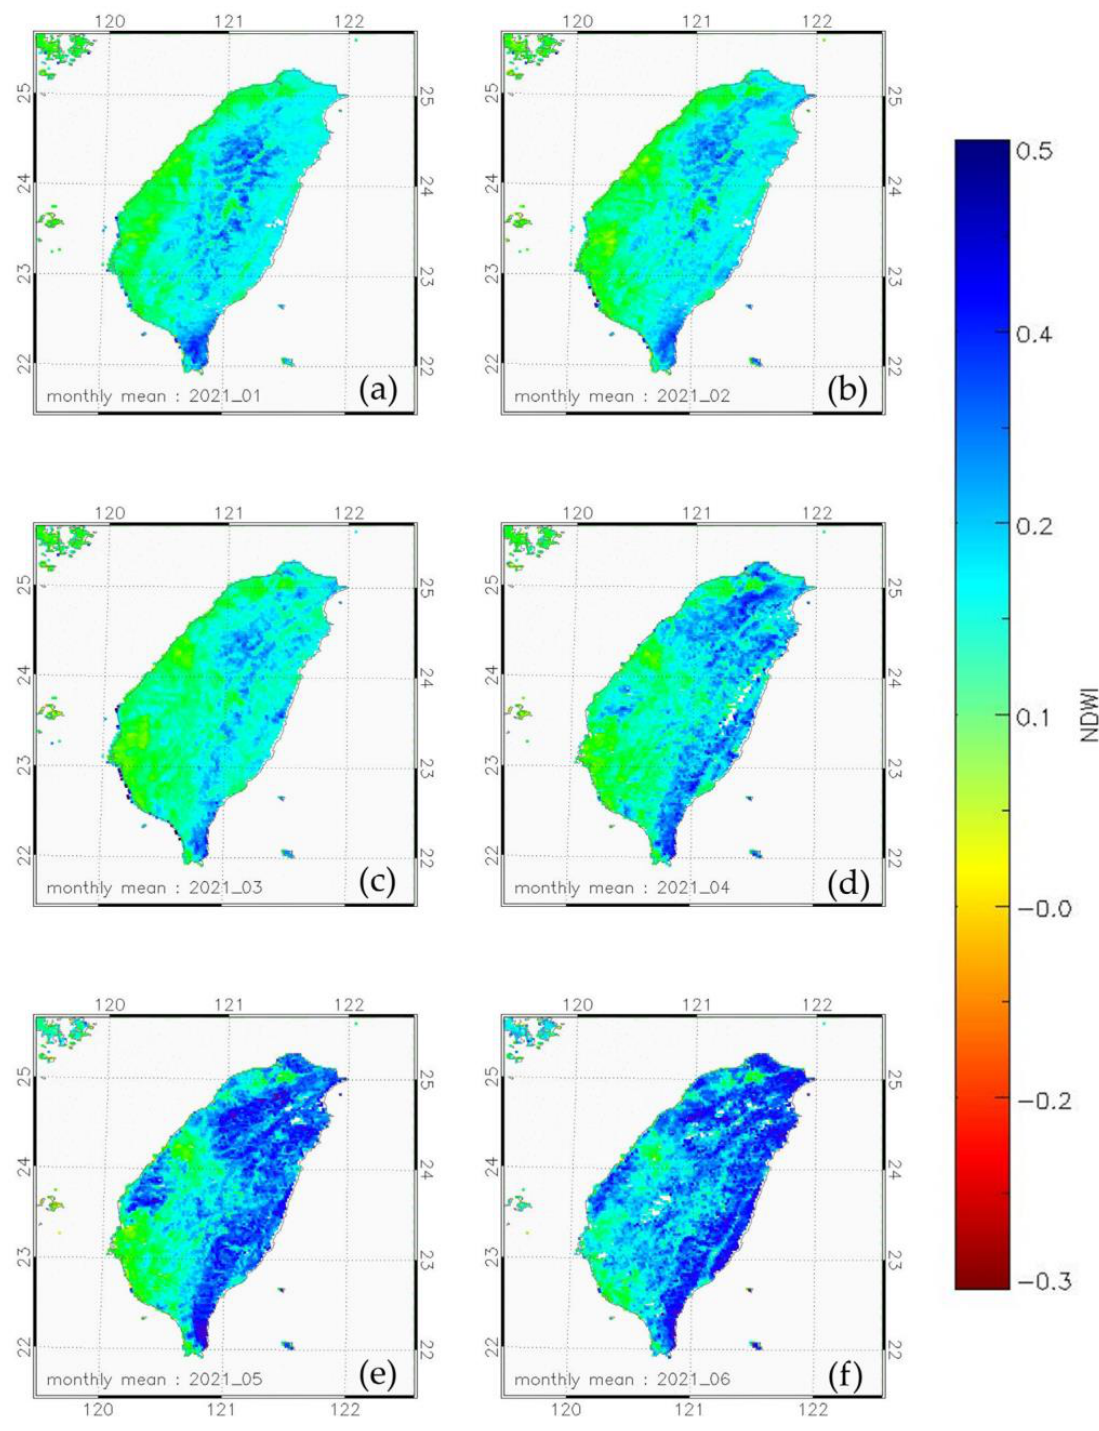
Figure 3. The mean value of NDWI (the version of [4]) over Taiwan from January to June 2021 (from ( a – f )). Color scale is shown at the right.